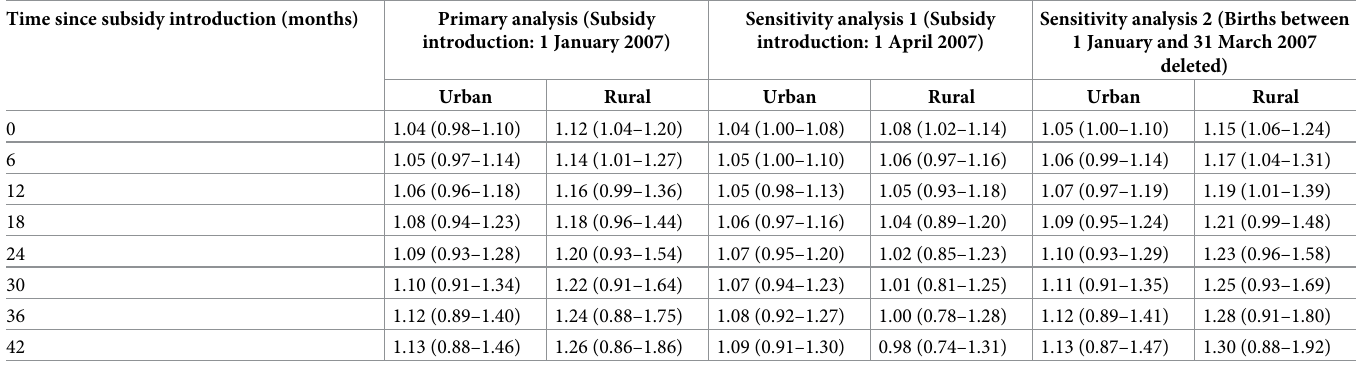
Table 4. Rate ratios (RRs) with corresponding 95% Confidence intervals (CIs) for associations between subsidy introduction and birth attendance in a health facil- ity over time across urban and rural locations in Burkina Faso. Time since subsidy introduction